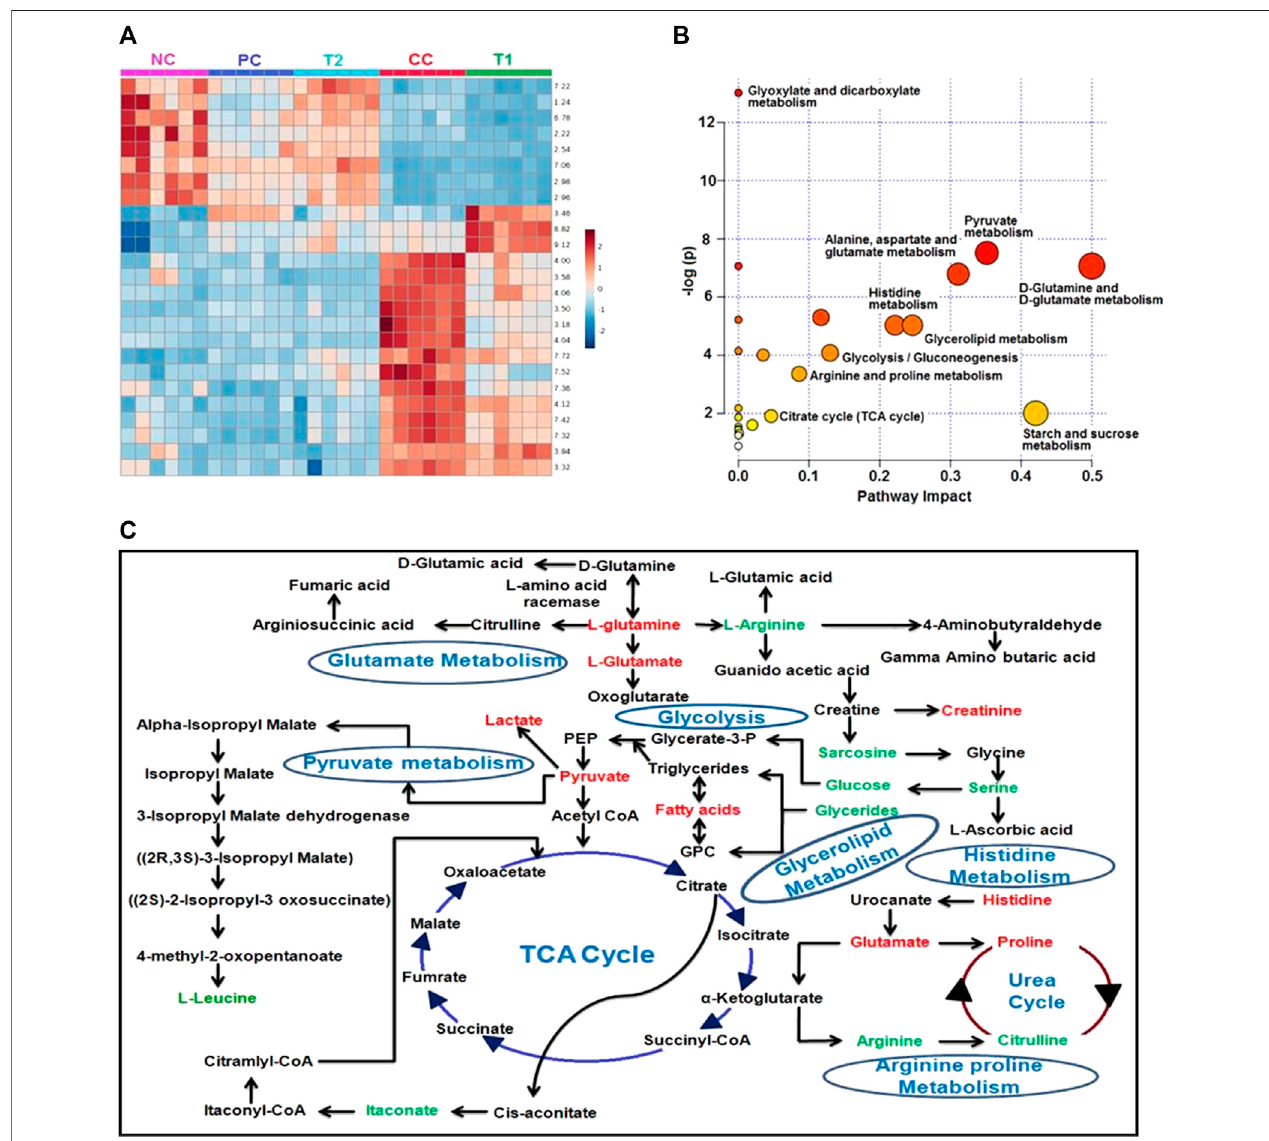
FIGURE 7 | (A) Heatmap of signi fi cant metabolites represented their concentration changing pattern. (B) Shows the module that supports pathway analysis of integrating enrichment analysis and pathway topology analysis and visualization for one model organisms. Pathways impact is shown the highly signi fi cant pathways of major metabolites. (C) Major metabolic pathways of the most relevant metabolites after DI treatments and CC group involved in glycolysis, glutamate metabolism, pyruvatemetabolism, glycerolipidmetabolism,Krebscycle,theureacycle,andhistidinemetabolism. Red:increasedconcentrationpro fi leofparticularmetabolites in the CC group. Green: decreased concentration pro fi le of particular metabolites in the CC